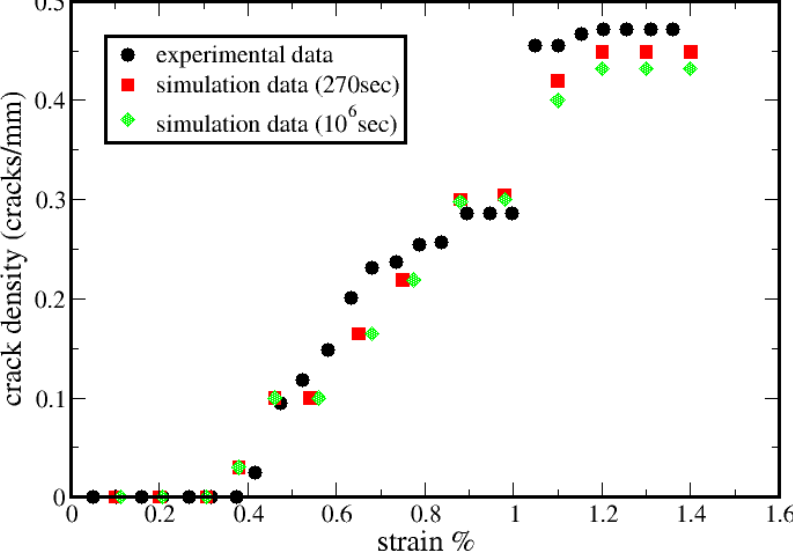
Figure 7. Crack density as a function of strain for experiment data [33] and simulation model data for quasi-static loading and for total loading time of about 270 s.